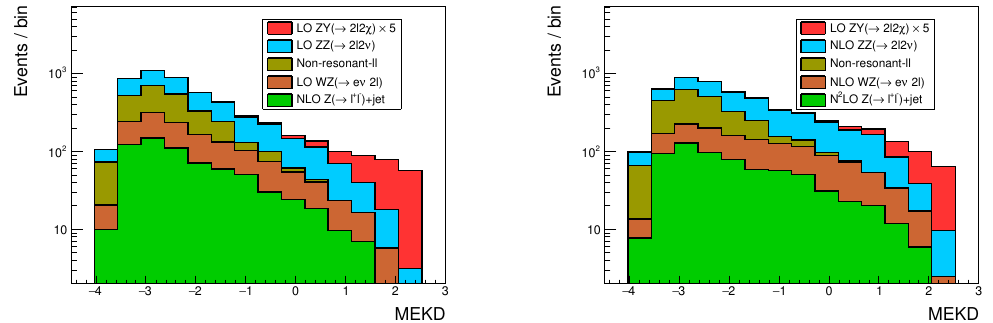
Figure 16 . Example MEKD distributions with MG5 generated events. The left plot is obtained with simulated events at LO accuracy. The right plot considers events of Z( at NLO accuracy. The signal considers S0 a benchmark model with (cid:21) = 3 : 5. We multiplied the signal yield by a factor of (cid:12)ve for a better